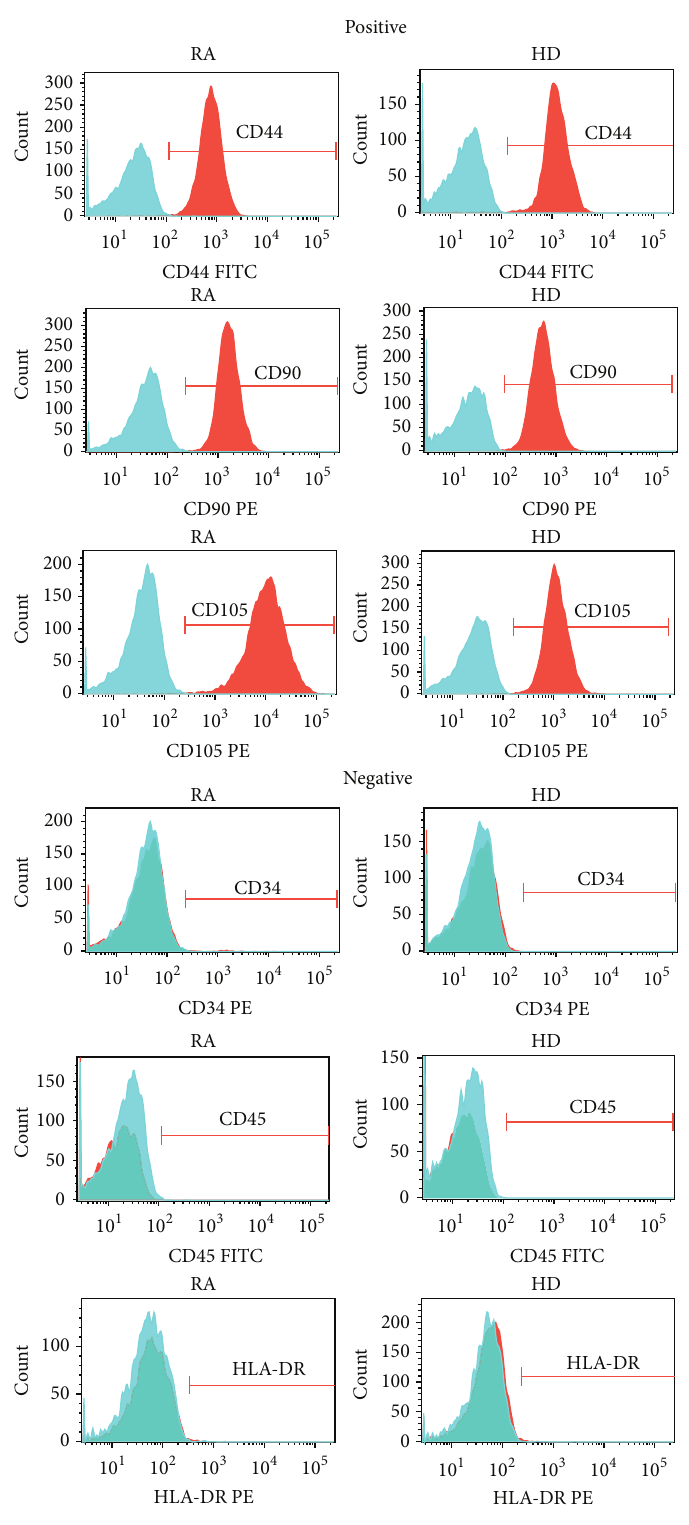
Figure 1: SMSC immunophenotypes. SMSCs from RA patients and HDs were positive for CD44, CD90, and CD105 and negative for CD34, CD45, and HLA-DR. Blue areas indicate background fluorescence of isotype control IgG, and red areas represent the fluorescence of the corresponding immunophenotype. The 𝑥 -axis represents fluorescence intensity, and the 𝑦 -axis represents cell